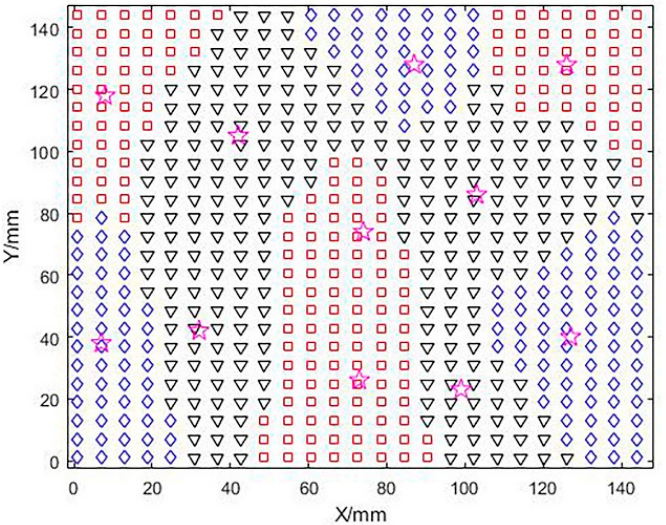
Figure 8. Cluster center and subdivision area.